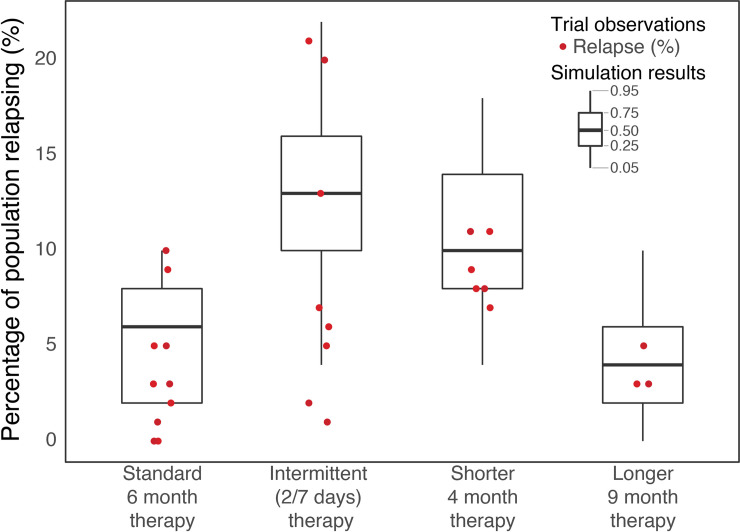
Comparison of therapy outcome for simulation vs. summary of previous clinical trials.Comparison of simulated population consisting of 5000 patients (boxplot) therapy outcome vs. summary of previous clinical trials in terms of risk of relapse as percentage of overall population grouped by changes in duration and frequency of standard therapy. Clinical trial data with individual therapy simulations used for this figure is summarised in the Addendum B.